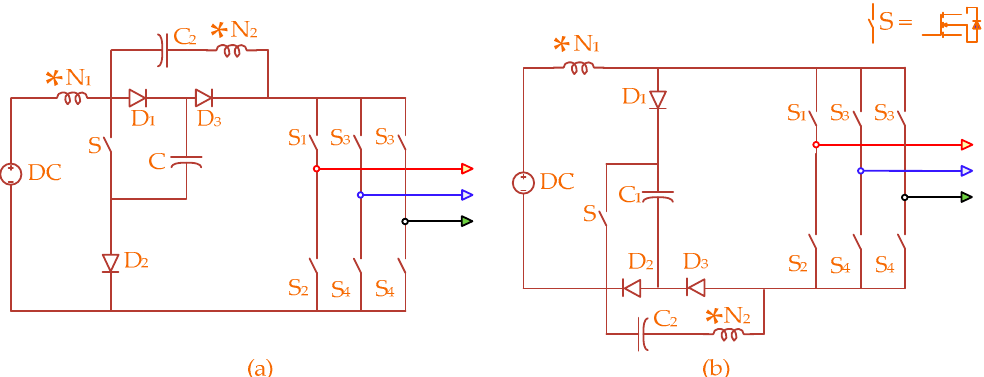
Figure 12. Coupled-inductor based quasi-switched boost inverter topologies (CI-qSBI). ( a ) Single cell CI-qSBI Type 1; ( b ) Single cell CI-qSBI Type 2.